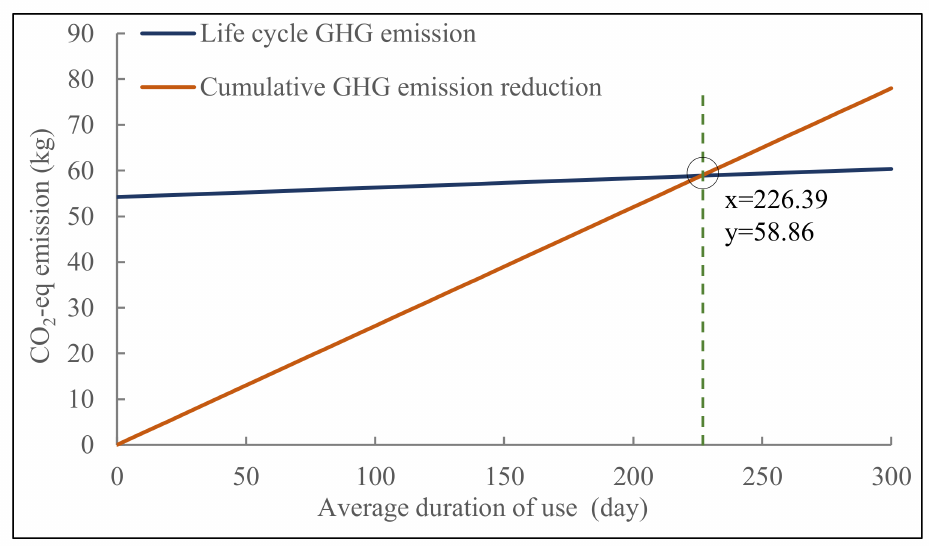
Figure 4. Equilibrium point of